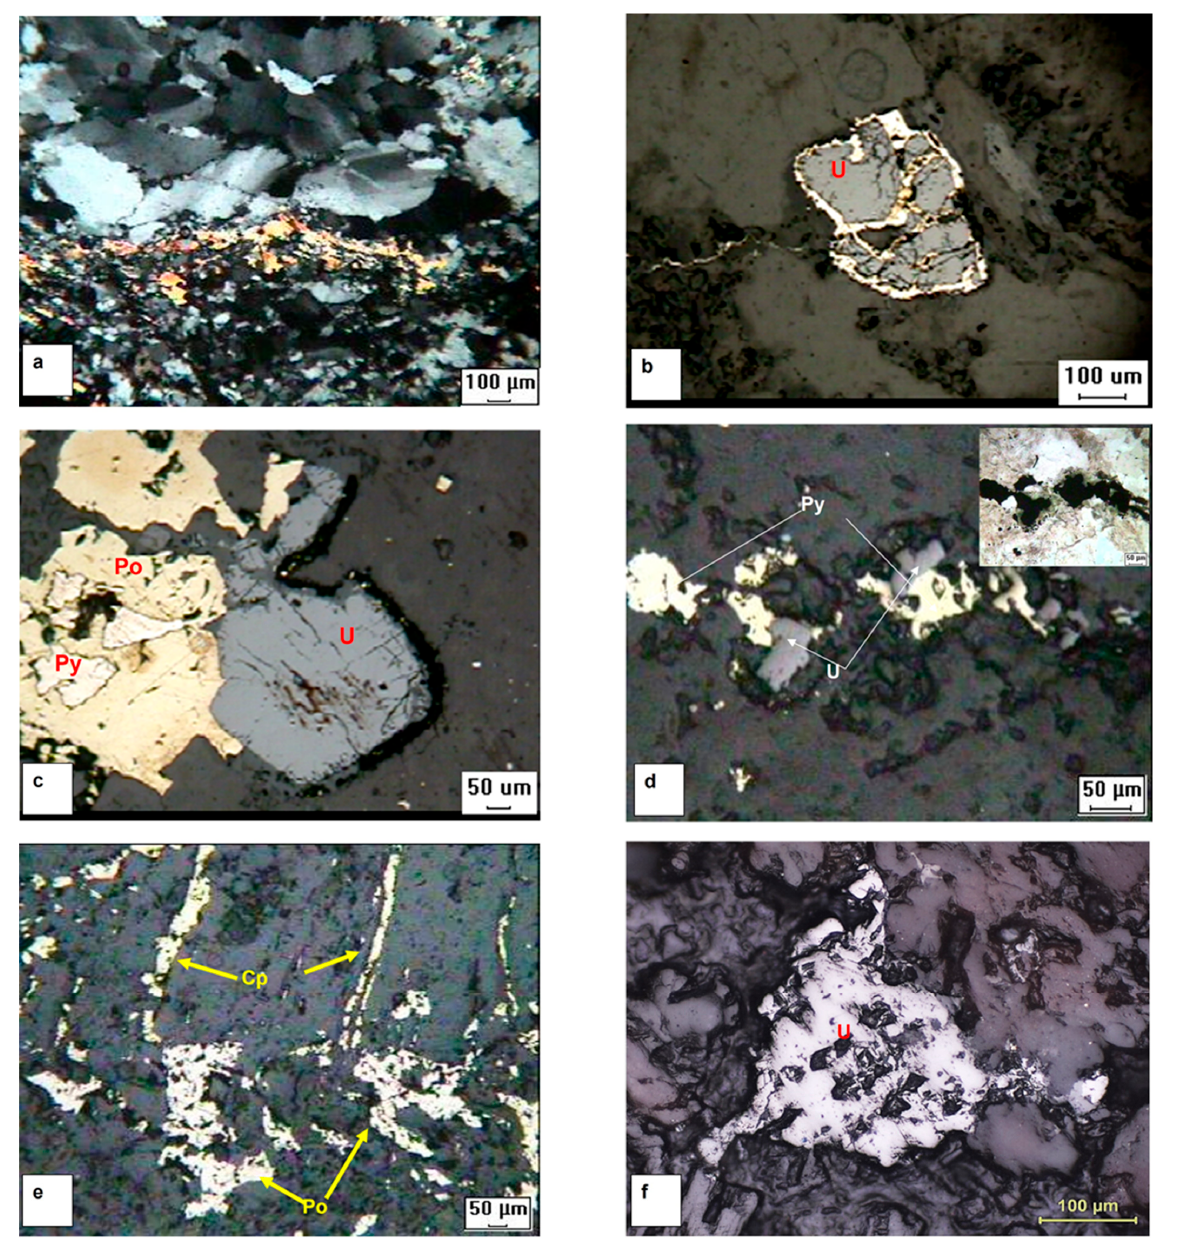
Figure 9. Photomicrographs. ( a ) Sharp contact between quartzite and the QFBS; the effect of shearing led to the stretching of grains parallel to the plane of contact; transmitted light (TL), under cross nicol(ucn); ( b , c ) the sharp grain boundary between uraninite and sulphides (pyrite, pyrrhotite, and chalcopyrite) indicate their co-genetic origin; ( d ) uraninite and pyrite along a vein, secondary chlorite envelope around uraninite in albite-rich groundmass under reflected light (RL), inset: same image under TL; ( e ) two sets of fractures; earlier fractures are filled by chalcopyrite (Cp), which are slightly truncated by later pyrrhotite (Po) veins; ( f ) uraninite aggregate formed with limbs of protrusions at 120 ◦ from the apex of the triple junction containing